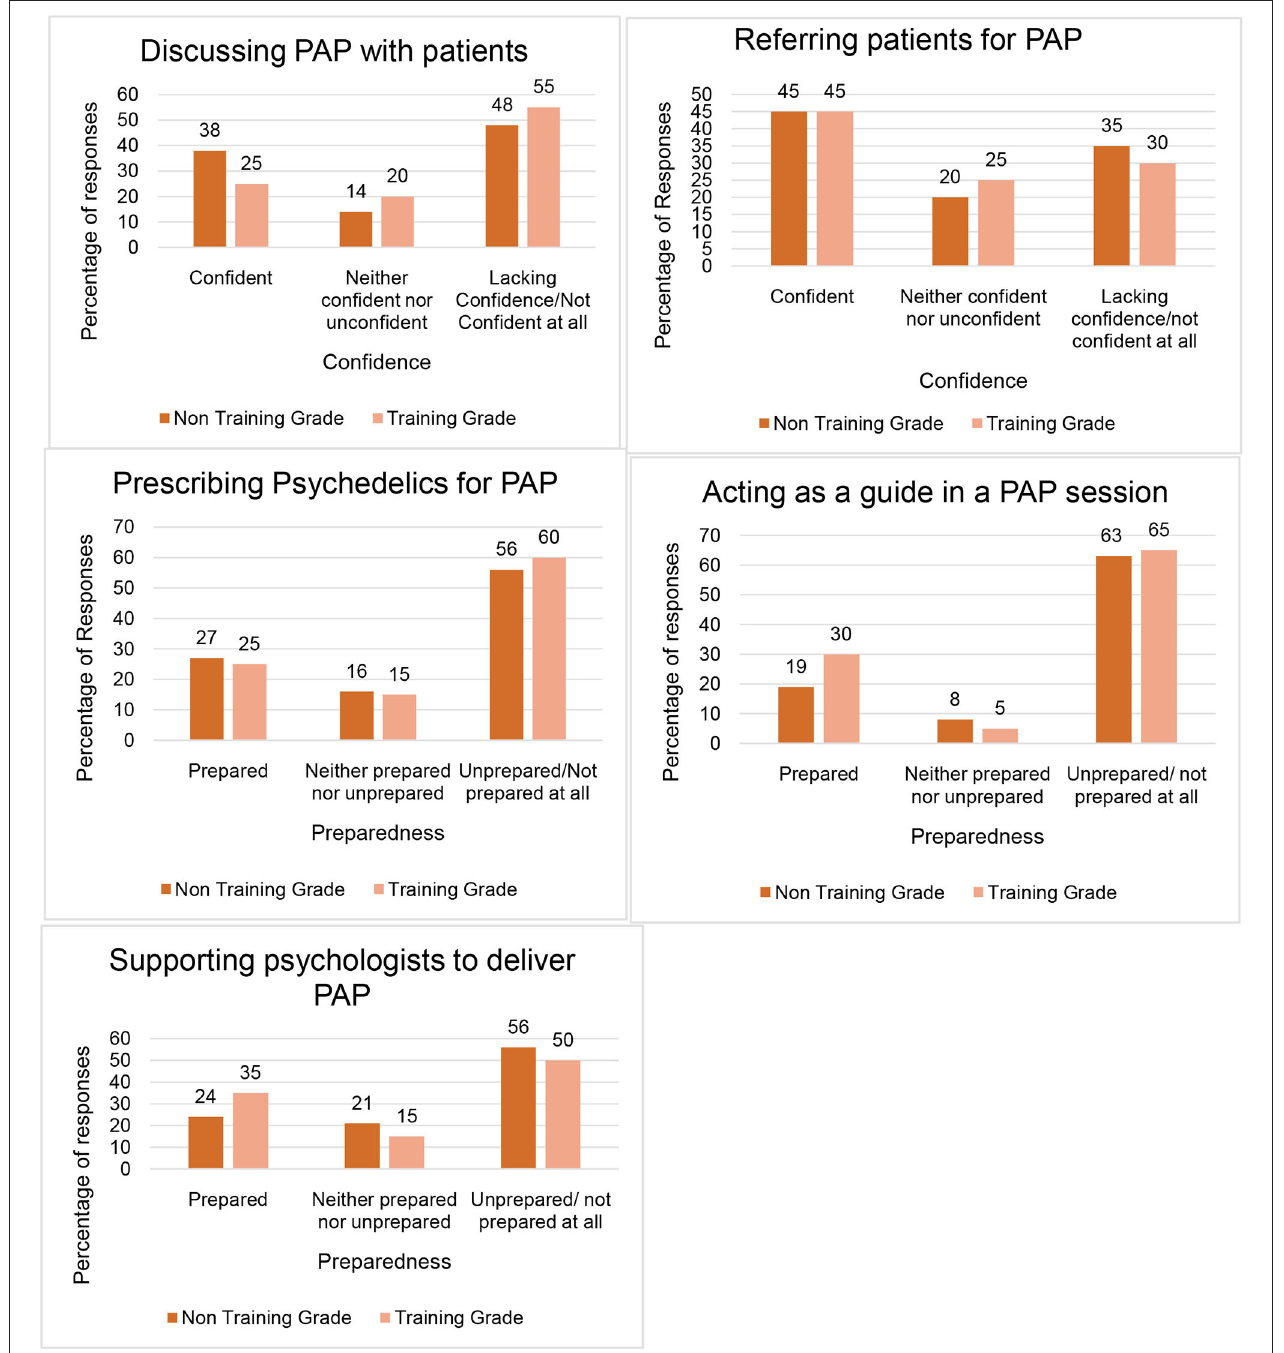
FIGURE 2 | Psychiatrists’ confidence and preparedness to be involved with Psychedelic- Assisted Psychotherapy. This figure outlines how confident and prepared Psychiatrists felt to participate in various aspects of PAP. Total number of responses = 83; Training grade psychiatrists = 20; Non-training grade psychiatrists =